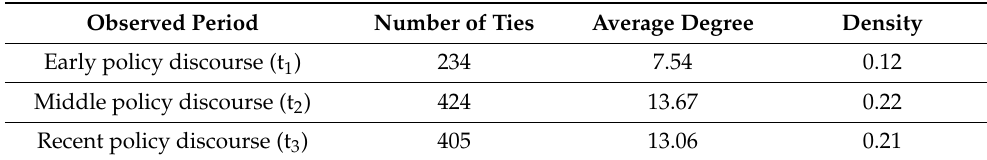
Table 1. Structural characteristics of policy communication networks among Ki-no-Eki organizations over